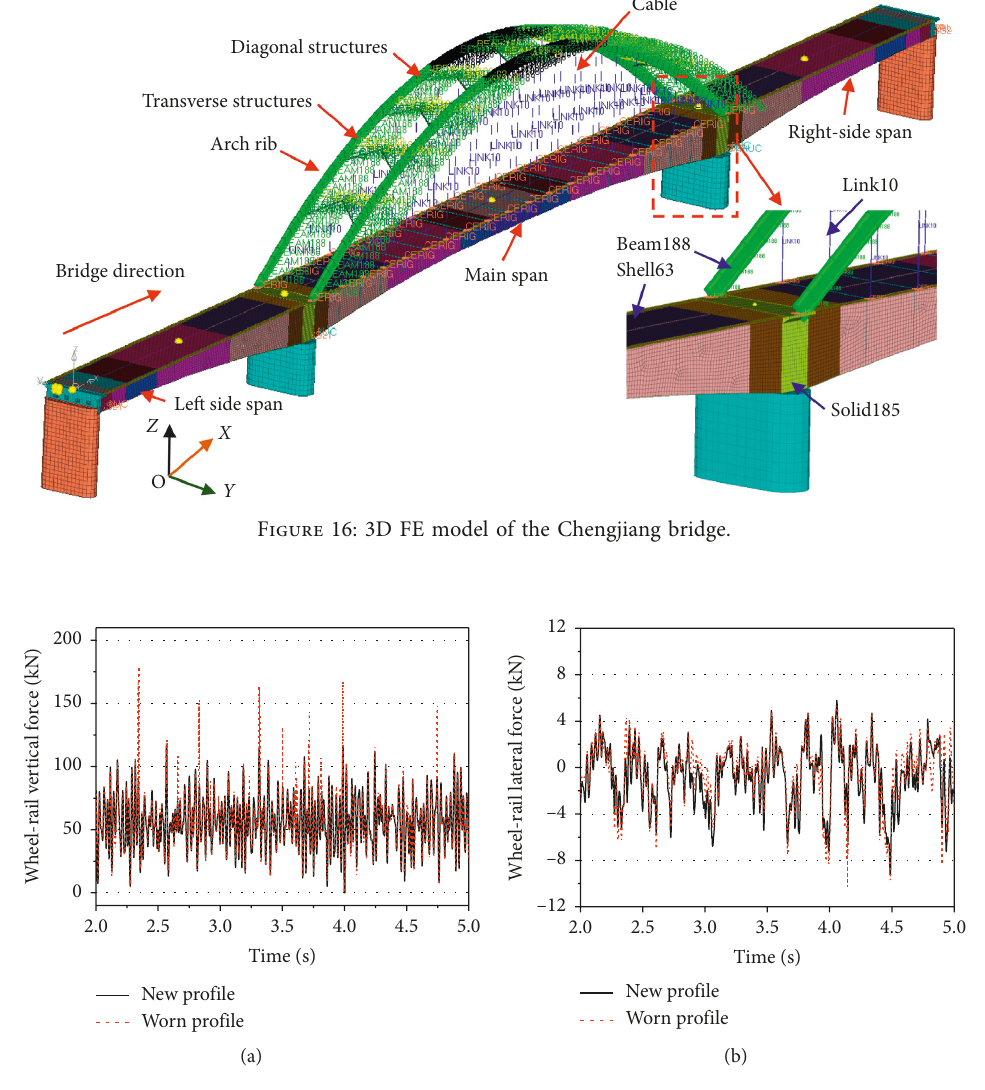
Figure 17: Wheel-rail force: (a) vertical; (b) lateral.